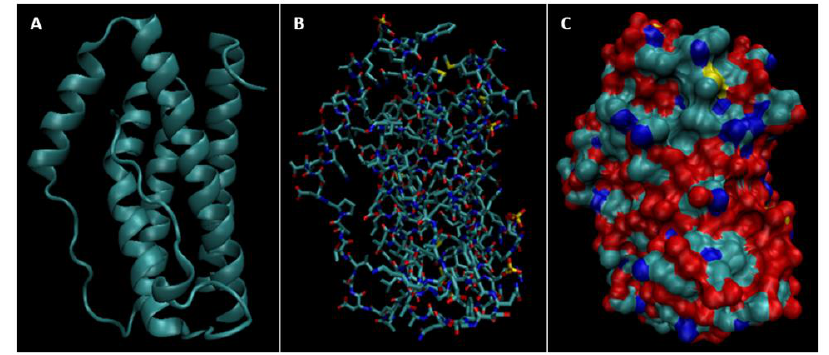
Figure 15. ( A ) A cartoon model, ( B ) a bonds model, and ( C ) a surface model of IL-6.